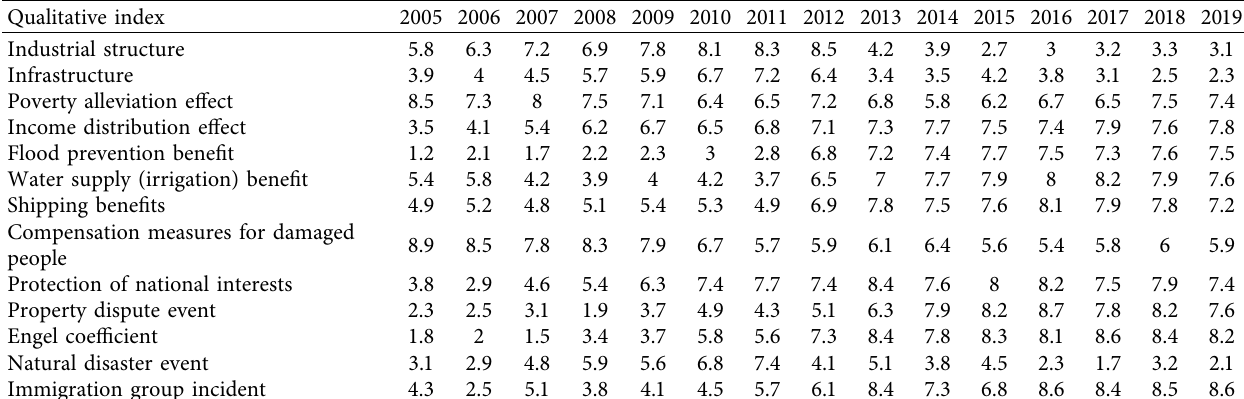
Table 3: Scoring result of Y hydropower station social impact assessment